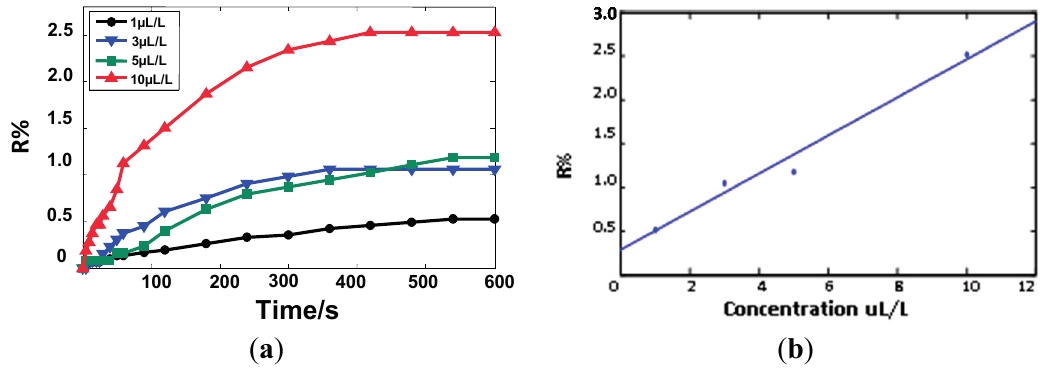
Figure 4. The gas-sensing properties of Ni-CNTs sensors to different concentrations of C 2 H 2 . ( a ) Gas-sensitivity to different concentrations of C 2 H 2 ; ( b ) Liner fitting curve.